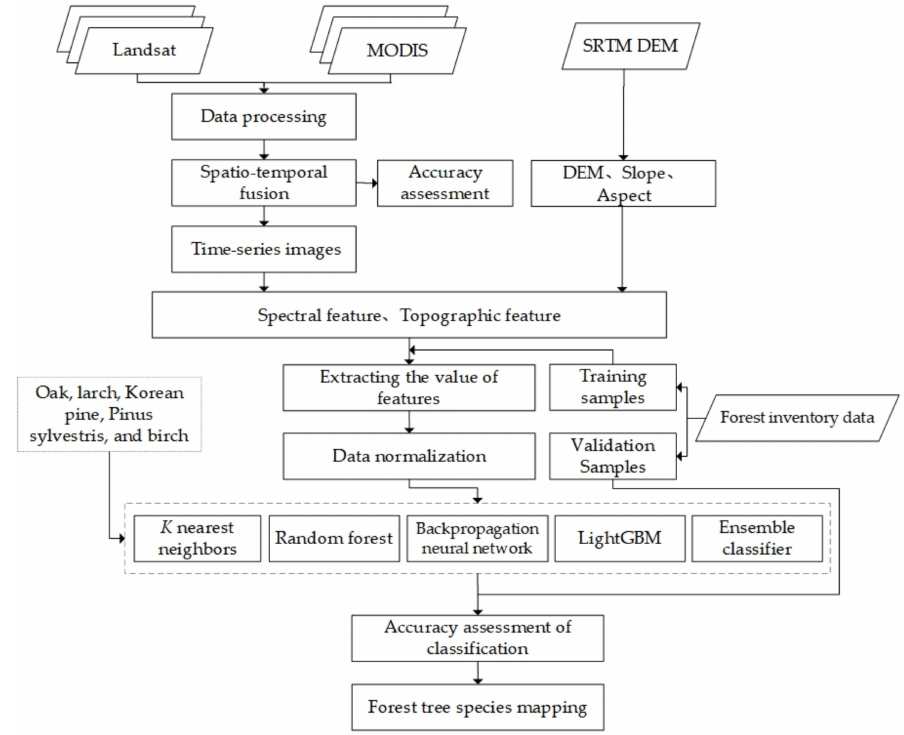
Figure 2. Flow diagram of tree species classification. The content bordered by a short dotted line represents the dominant tree species to be classified, and the content in the long dotted line box is several machine learning methods for